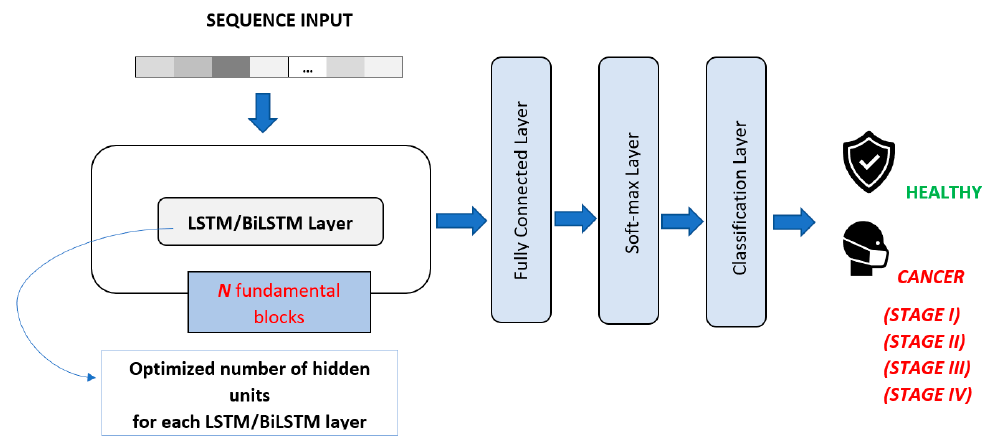
Figure 6. Proposed LSTM and BiLSTM architectures. (Illustrations by the authors).